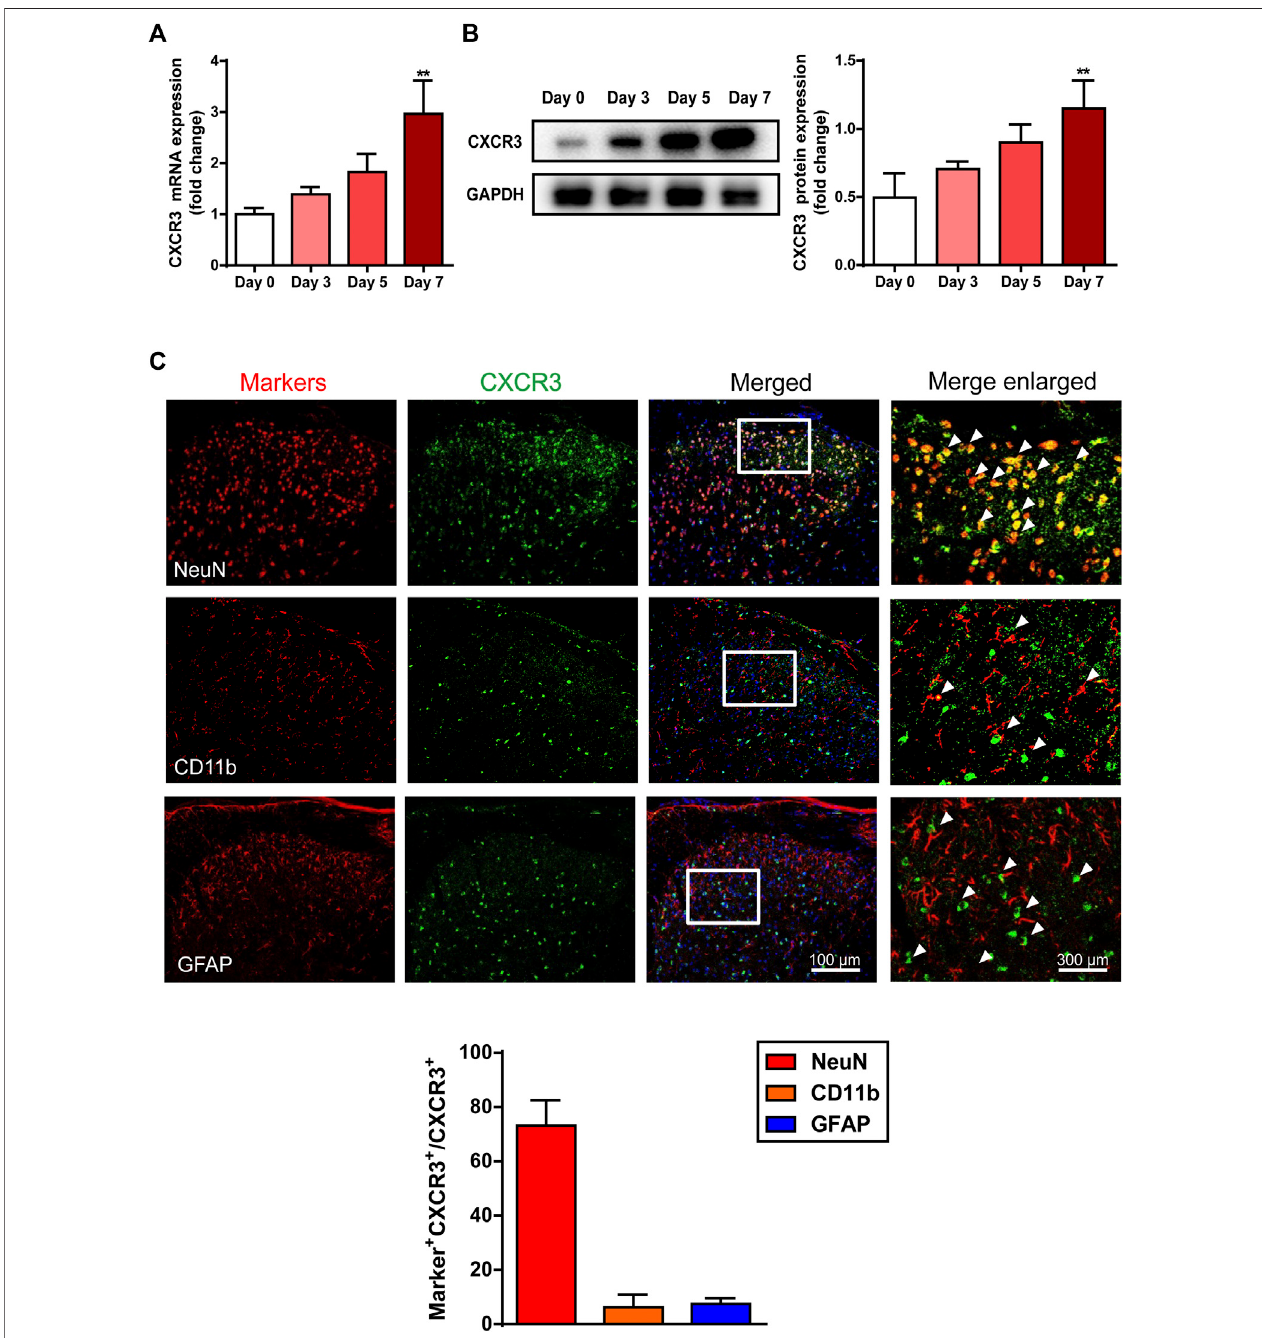
FIGURE 5 | Theexpressionpro fi leofCXCR3inthespinalcordintheAEW-stimulatedmice.ThemRNA (A) andprotein (B) levelofCXCR3inthespinalcordincreased as stimulation of AEW went on ( n (cid:1) 3 – 7 each group). (C) Immuno fl uorescence co-staining images of CXCR3 with neuron marker (NeuN), microglial marker (CD11b) and astrocyte marker (GFAP) in the spinal dorsal horn of AEW mice ( n (cid:1) 4 each group). Data were expressed as mean ± SEM. pp p < 0.01, compared to the Day 0 group.